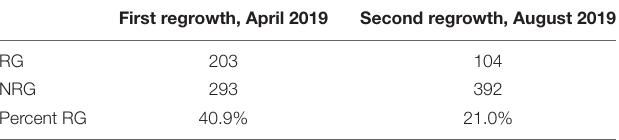
TABLE 1 | Number of regrown (RG) and non-regrown (NRG) plants in P39/“Gigi” F 2 greenhouse-grown plants planted in 2018 and scored after one and two cycles of regrowth in